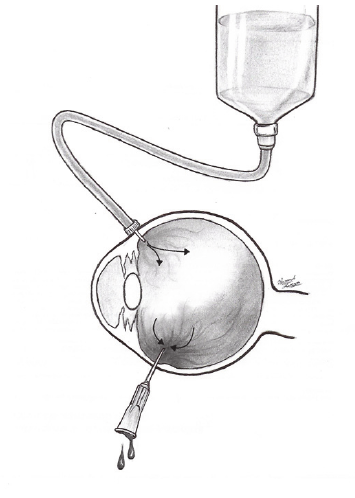
Figure2:SchematicdrawingshowingtheBSSfluidfromanelevated bottle entering the eye through the infusion cannula and egressing through the needle lavaging the hemorrhagic vitreous